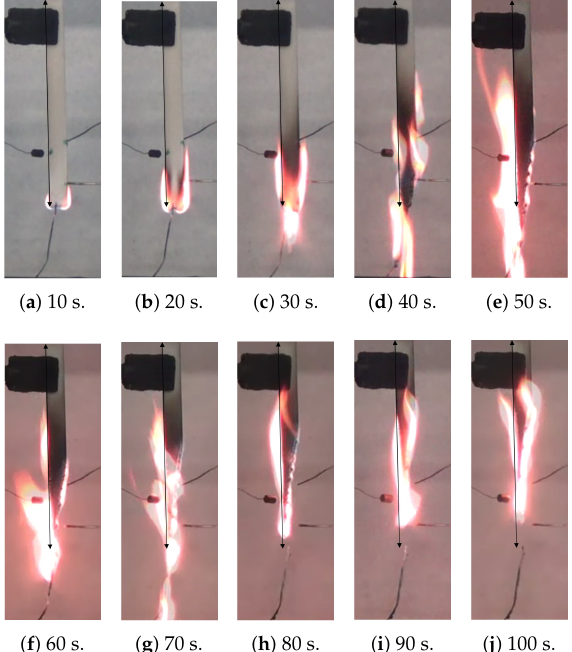
Figure 4. Images of the UL 94 test at different time steps.